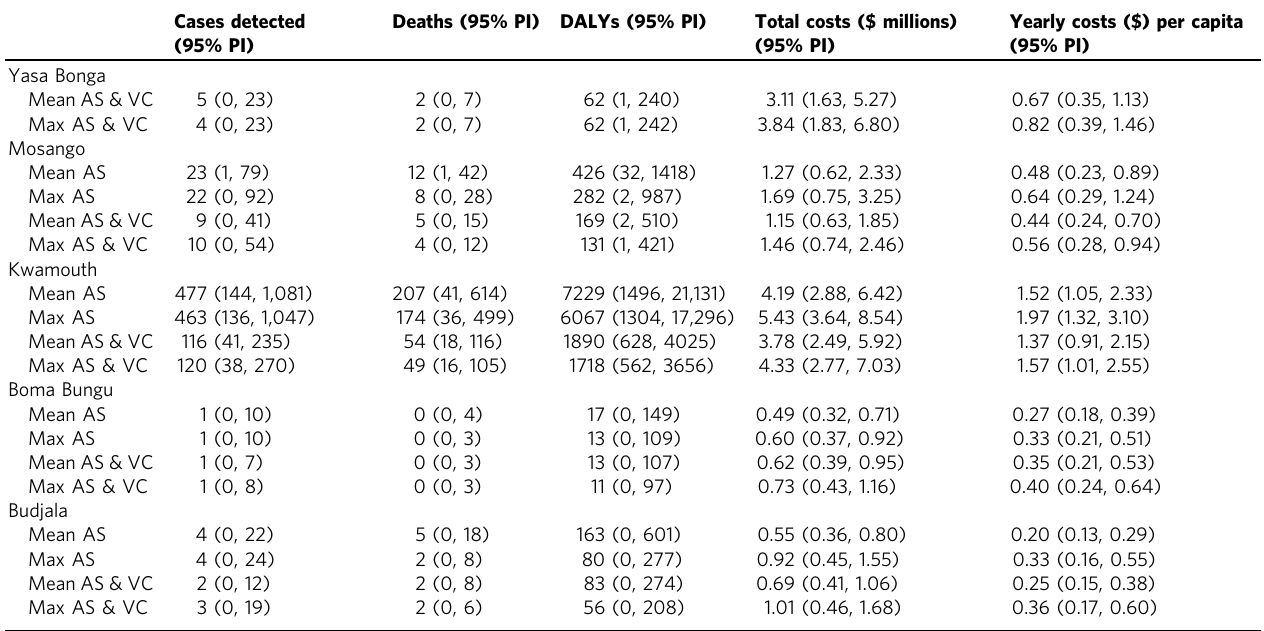
Table 3 Summary of effects and costs 2020 –